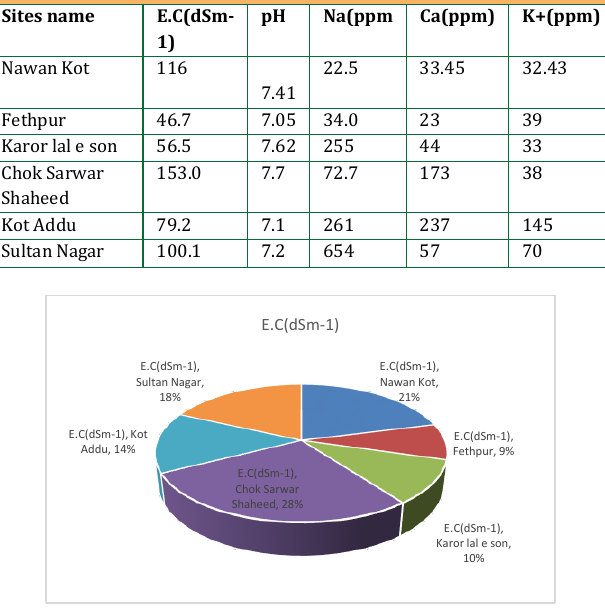
Table: 13: Analysis of soil samples collected from wheat field of various site of district Layyah and Muzaffargarh